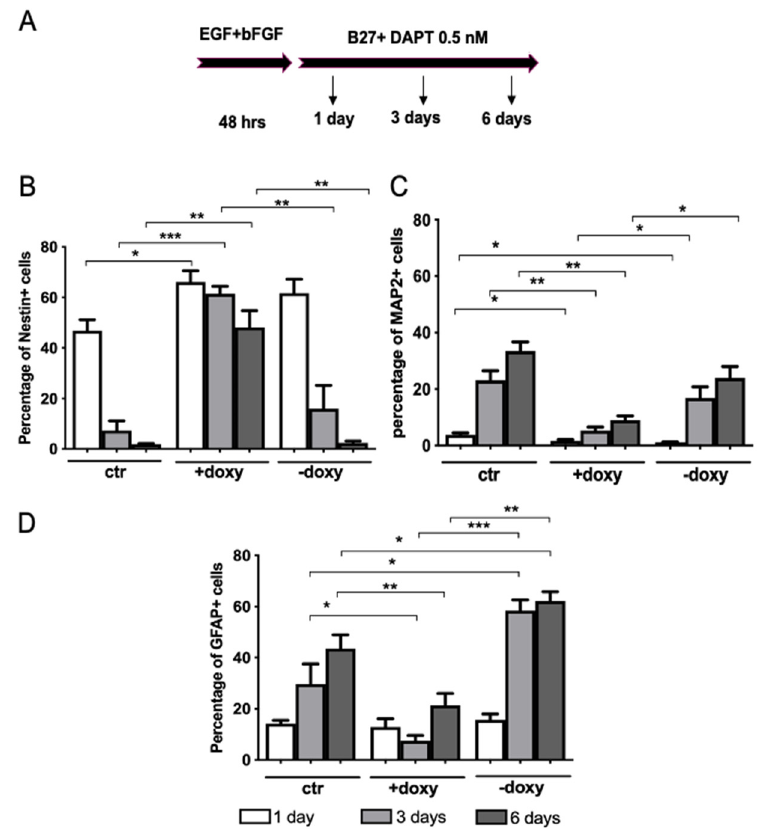
Figure 4. Neuronal differentiation of NSPCs is impaired by the expression of hWT-FUS. ( A ) Schematic representation of the procedure used to quantify the neuronal, glial and undifferentiated population obtained upon 6 days of differentiation. NSPCs were maintained in expansion medium (EGF + bFGF) supplemented with or without doxycycline for 48 h. The cells were then switched to neuronal differentiation medium (B27 + DAPT 0.5 nM) for 24 h, 3 days and 6 days. ( B – D ) Quantification of the percentage of stemness marker Nestin ( B ) and differentiative markers, respectively neuronal MAP2 ( C ) and glial GFAP ( D ), immunopositive cells after 1 day, 3 days and 6 days. The NSPCs ”+doxy” were maintained with doxycycline both under proliferative and differentiative conditions, while ”-doxy” where exposed to doxycycline only during the first 48 h (proliferative condition). Data are presented as a mean ± SEM of 3 independent experiments. Mann-Whitney test * p < 0.05 ** p < 0.01 *** p <